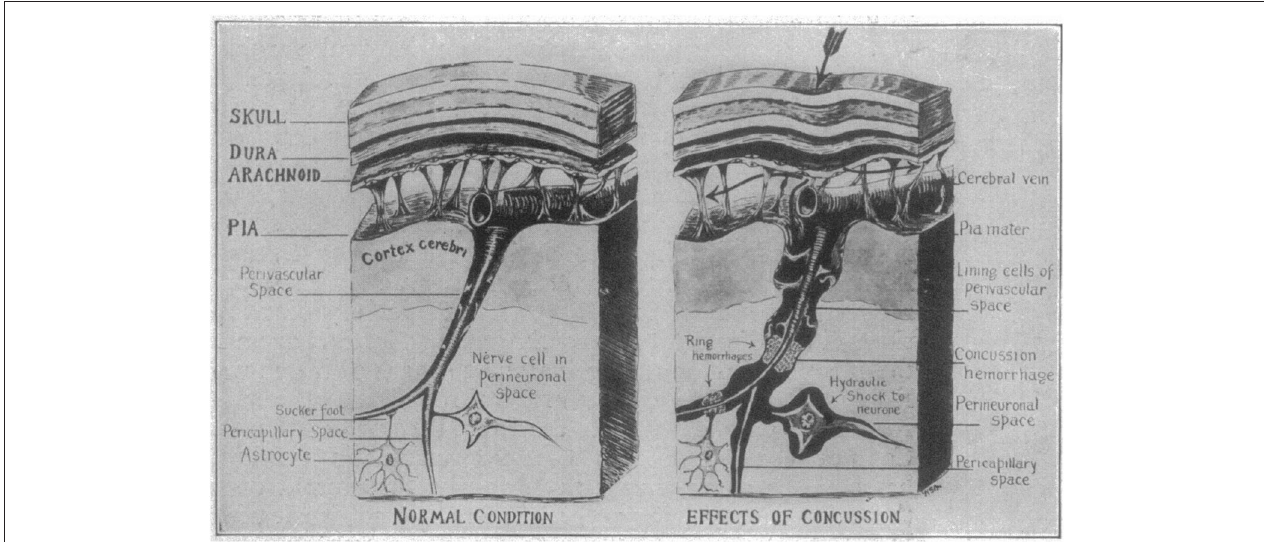
FIGURE 1 | Schematic of Cassasa’s hypothesis of concussion described by Martland in 1928, which he attributed to Charles B. Cassasa. The first step is an indentation of the skull caused by a mechanical force. A hydrostatic pressure wave then travels from the subarachnoid space and along the perivascular space to produce ring hemorrhages and hydrostatic shock to the neurons. Reproduced with permission from Martland